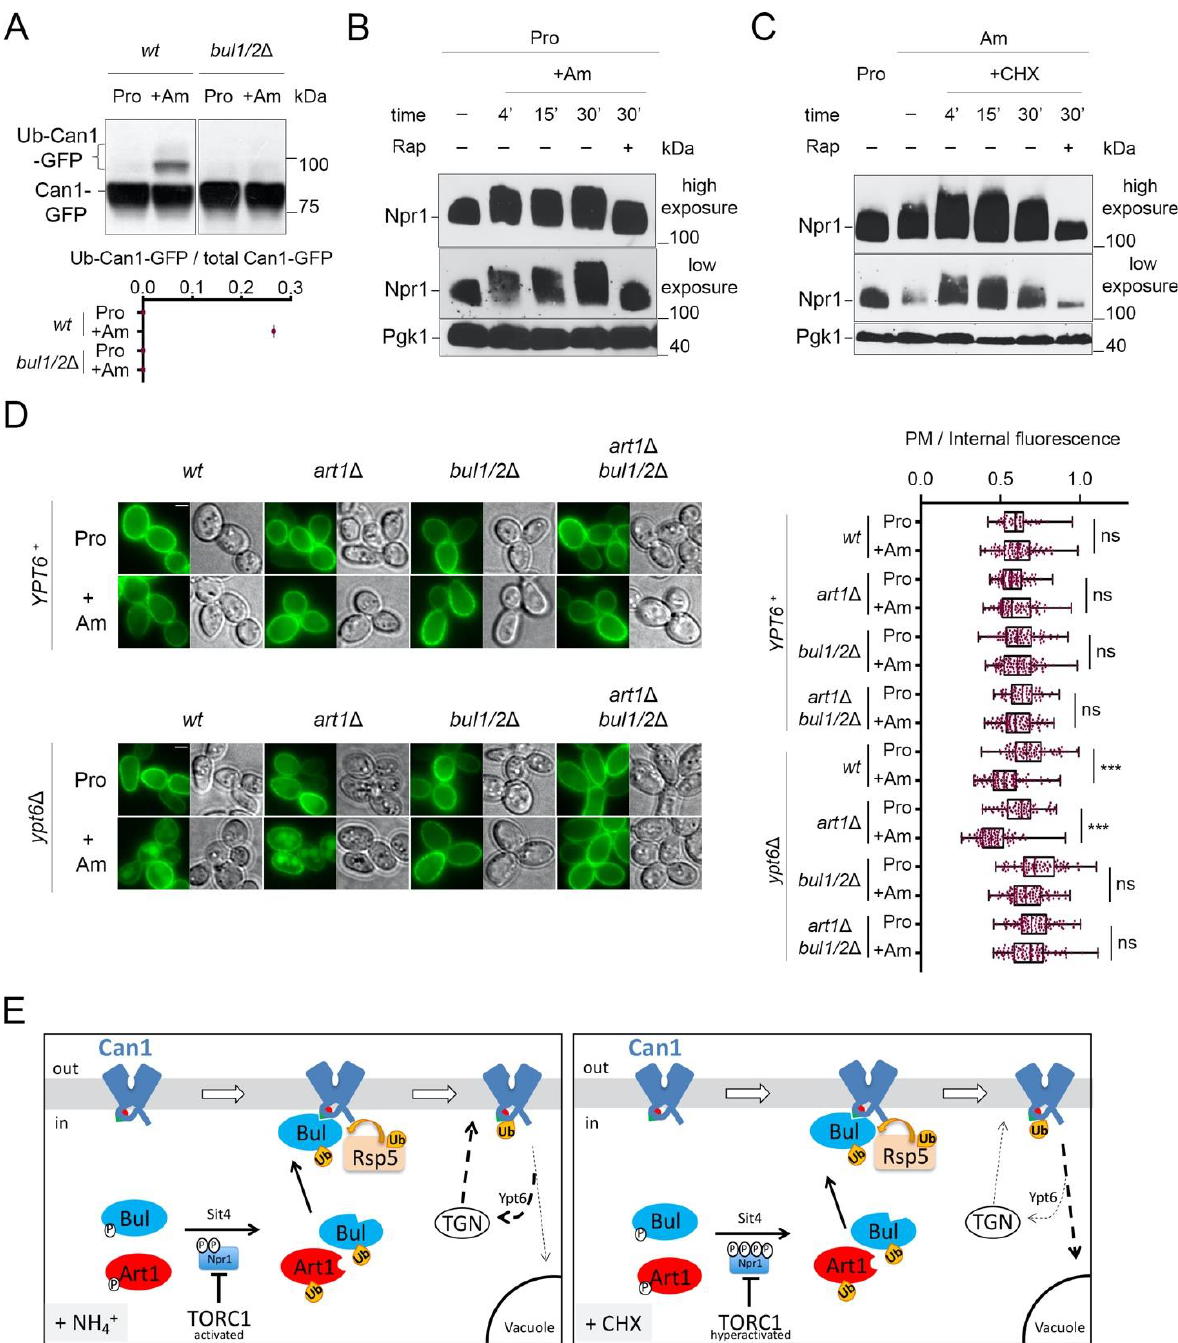
Figure 4. Cycloheximide promotes endocytosis of Can1 via TORC1 hyperactivation and/or blockage of transporter recycling. ( A ) Immunoblots of total protein extracts of wt and bul1/2 Δ cells expressing Can1-GFP. Cells were grown on Gal Proline (Pro) medium. Glu was added for 30 min followed by Am for another 30 min. Total protein extracts were probed and analysed as in Figure 2B. The low mobility bands correspond to Ub-Can1-GFP conjugates. Quantifications: The ratio of Ub-Can1-GFP / Total Can1-GFP are plotted in scattered plots from one biological replicate. ( B ) Immunoblots of total protein extracts of a wild-type strain expressing HA-Npr1 and grown in Pro medium, followed by the addition of Ammonium (Am). Samples with or without rapamycin addition 15 min after Am addition were collected at the indicated timepoints and probed with anti-HA and anti-Pgk1 antibodies. High and low exposures are shown. ( C ) Immunoblots of total protein extracts of a wild-type strain expressing HA-Npr1. Cells were grown on Gal Proline (Pro) or Ammonium (Am) medium, followed by the addition of CHX. Samples with or without rapamycin addition 15 min after CHX addition were collected at the indicated timepoints and probed with anti-HA and anti-Pgk1 antibodies. High and low exposures are shown. ( D ) Epifluorescence microscopy of Can1-GFP in wt , bul1 / 2 Δ, art1 Δ, and art1 Δ bul1/2 Δ cells in YPT6 + or ypt6 Δ background, grown in Gal Pro medium. Glu was added for 1 h followed by addition of Am for 3 h. Quantifications: Plasma